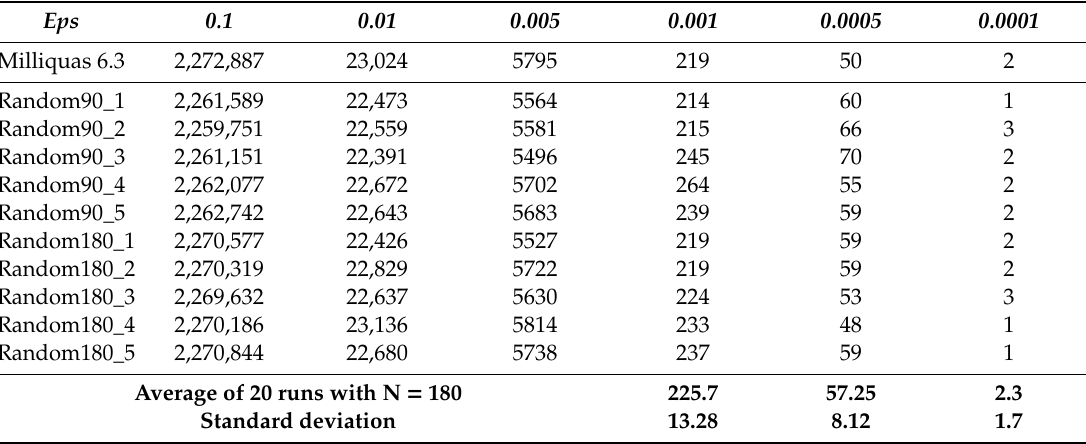
Table 23. Number of opposite pairs for selected angular accuracy values eps in the Milliquas 6.3 catalog and in several random catalogs with the same number of objects and the same angular distribution on the celestial